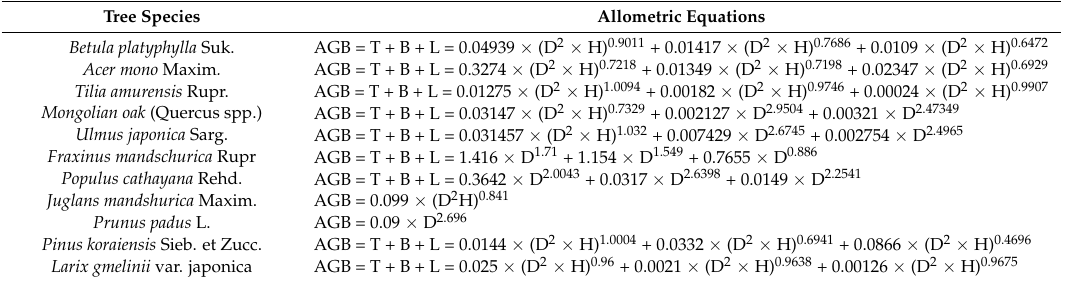
Table 2. Main allometric equations for the above-ground biomass calculation of each tree species [53,54]. Tree Species Allometric Equations Betula platyphylla